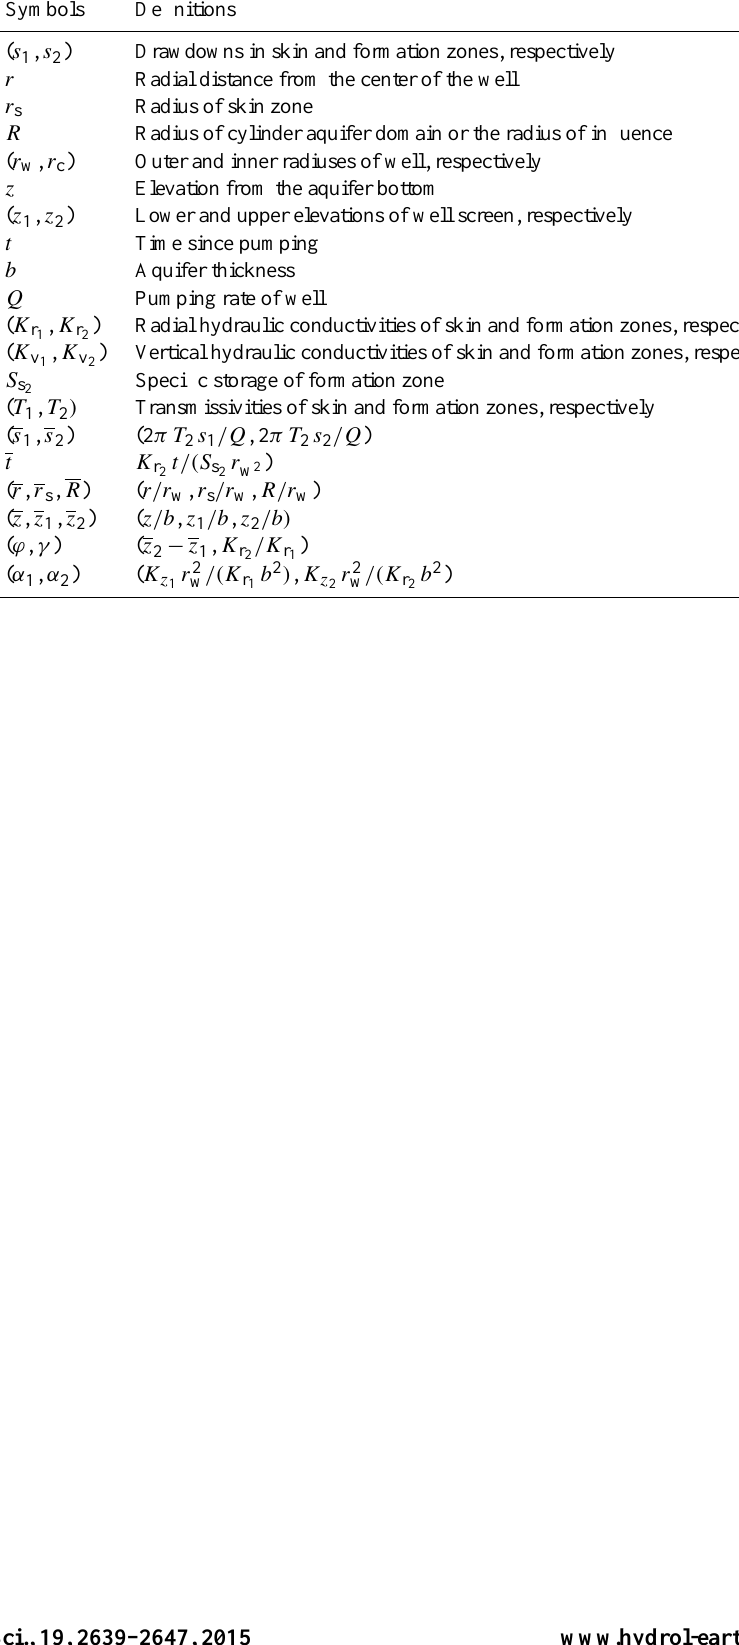
Table A1. Summary of symbols used in the text and their definitions. Symbols Definitions ( s 1 , s 2 ) Drawdowns in skin and formation zones, respectively r Radial distance from the center of the well r s Radius of skin zone R Radius of cylinder aquifer domain or the radius of influence ( r w , r c ) Outer and inner radiuses of well, respectively z Elevation from the aquifer bottom ( z 1 , z 2 ) Lower and upper elevations of well screen, respectively t Time since pumping b Aquifer thickness Q Pumping rate of well Radial hydraulic conductivities of skin and formation zones,